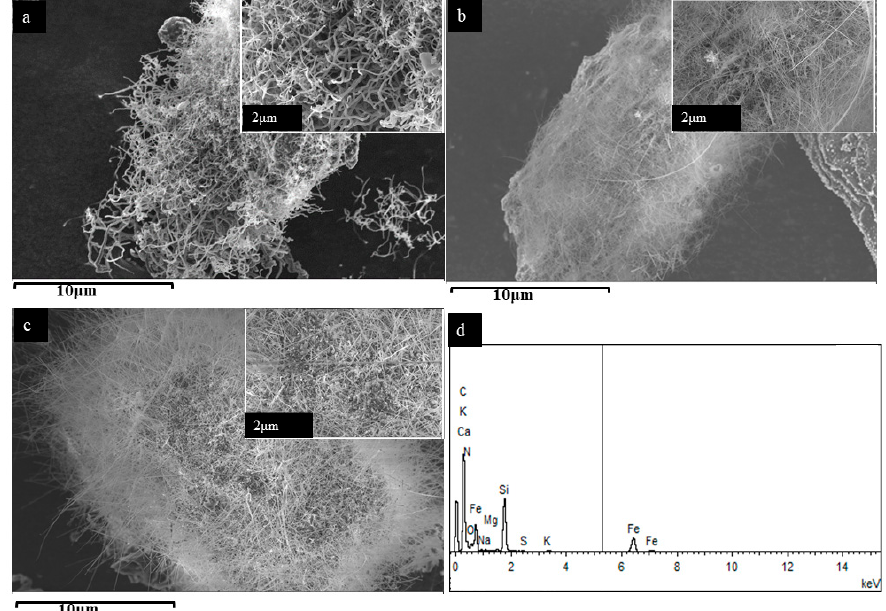
Figure 2. SEM images of SL-CNTs after microwave treatment: ( a ) 1200 °C, ( b ) 1300 °C, ( c ) 1400 °C, ( d ) EDS spectra of SL-CNTs prepared at 1300 °C. Magnified images (insets; top right).